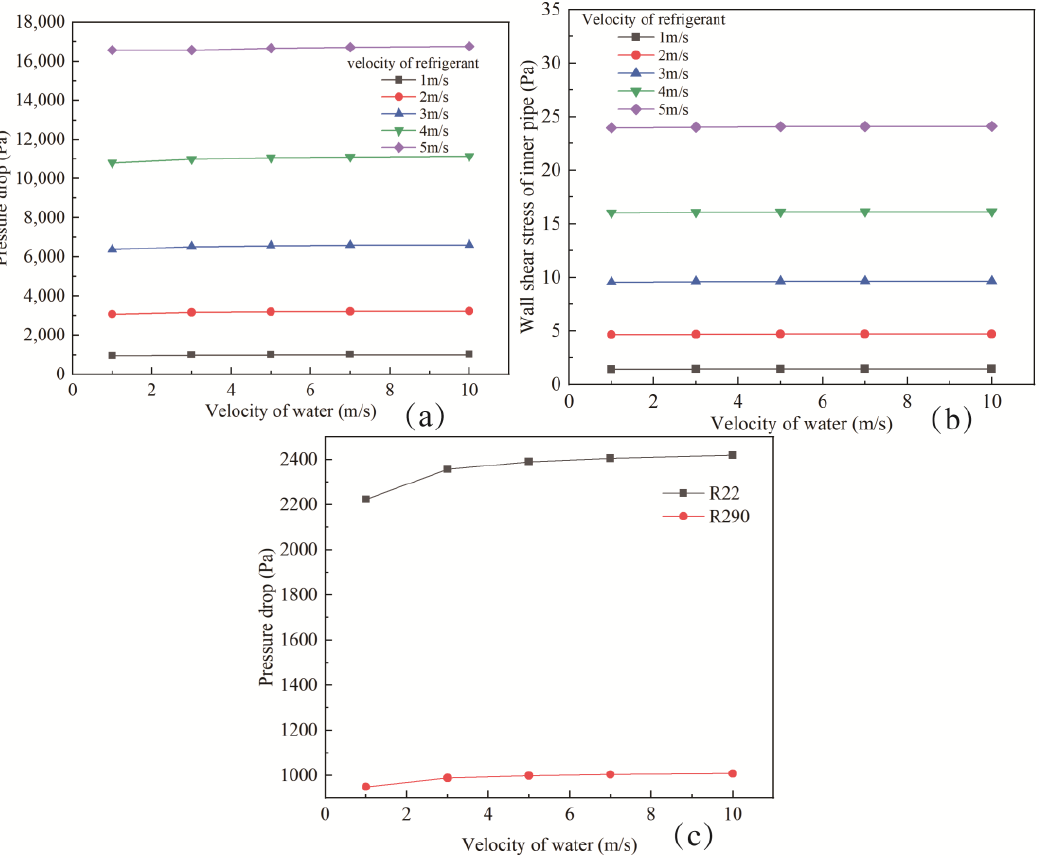
Figure 11. The impact of ( a ) water velocity on pressure drop, ( b ) wall shear stress of inner pipe and ( c ) pressure drop of R22 and R290 at different water velocities.